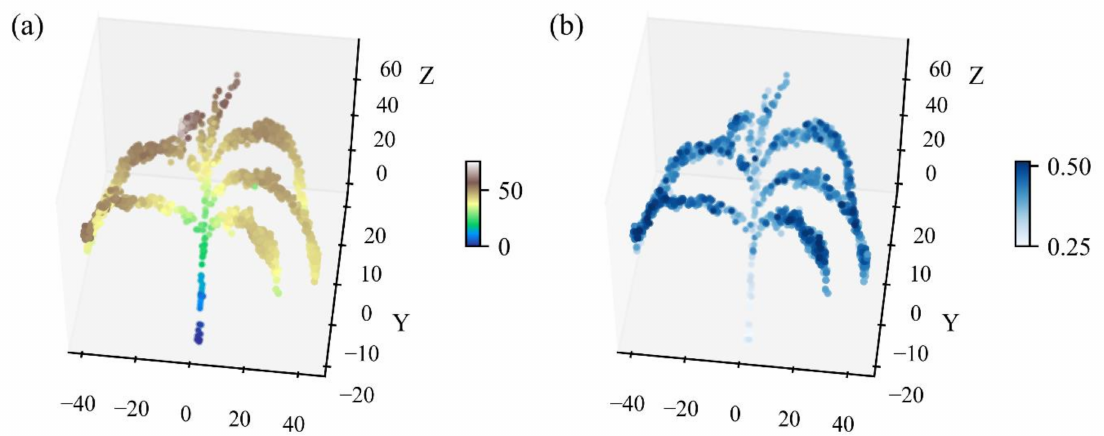
Figure 8. ( a ) Elevation distribution (cm) and ( b ) N concentration (%) distribution of 3D maize plants. The unit of X, Y, and Z is centimeters.